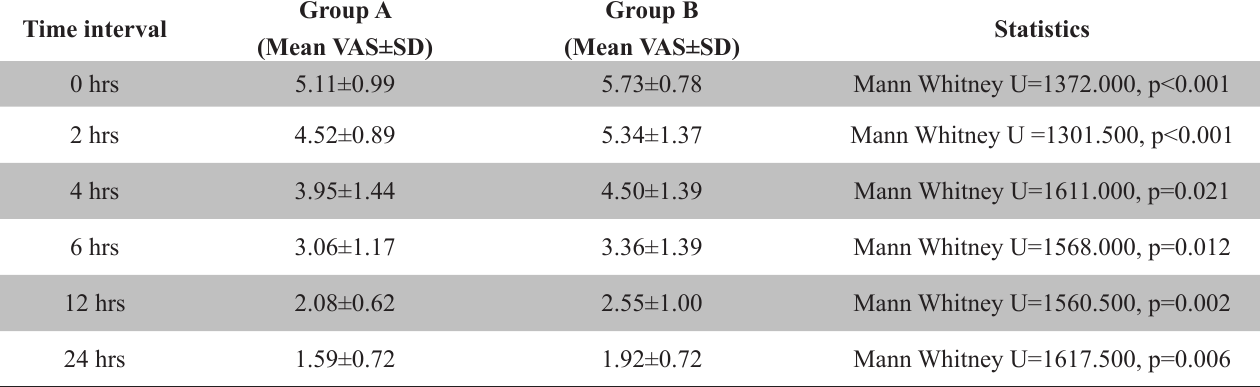
Fig 4. Comparison of mean respiratory rate (min -1 ) at different time periods Table 2. Comparison of mean VAS scores between Group A and Group